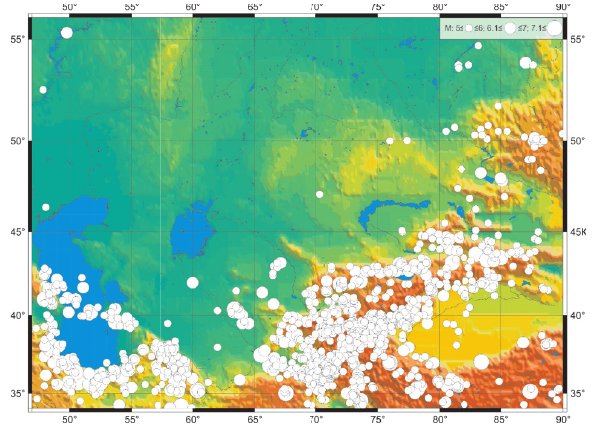
Figure 7. The map of the epicenters of large earthquakes of Cen- tral Asia with M ≥ 5 (from 2000 B.C. to 2009